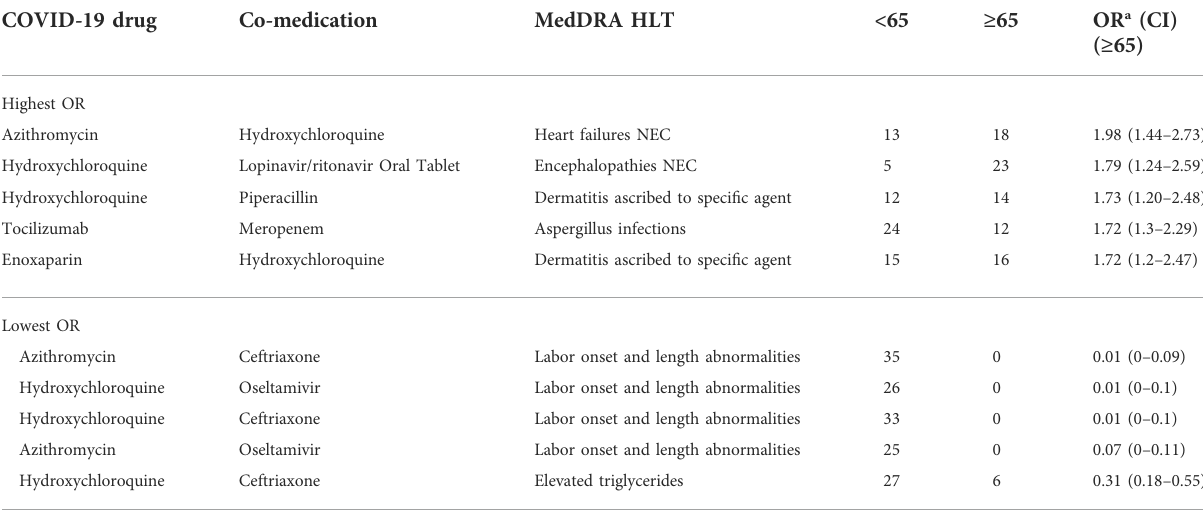
TABLE 2 The fi ve highest and lowest adjusted odds ratios (OR) of the DDI risk associated with age.